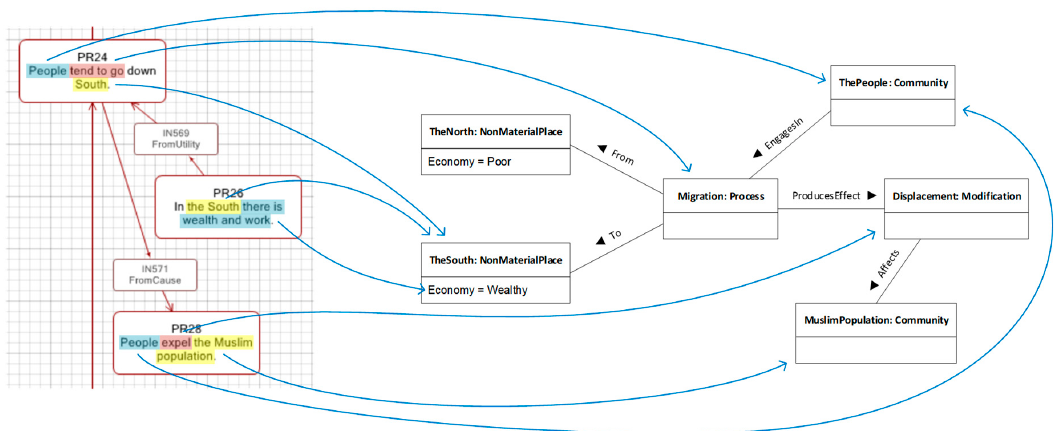
Figure 4. Diagram fragments for the discourse and domain models are displayed here. Blue arrows connecting them stand for the expected connections between elements in the discourse and elements in the domain. Discourse fragments have been highlighted in different shades for clarity. For example, the words “tend to go” in proposition PR24 (top left) must be connected to the Migration: Process entity (centre right).